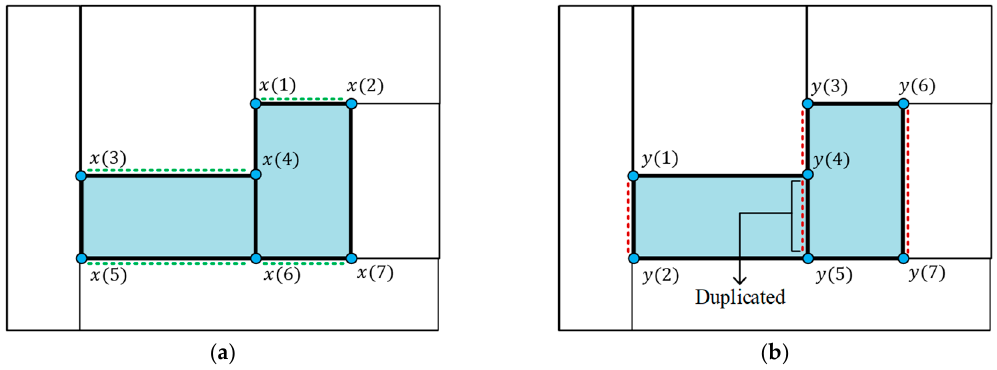
Figure 2. Loop distance measurements. ( a ) On the x axis; ( b ) On the y axis.